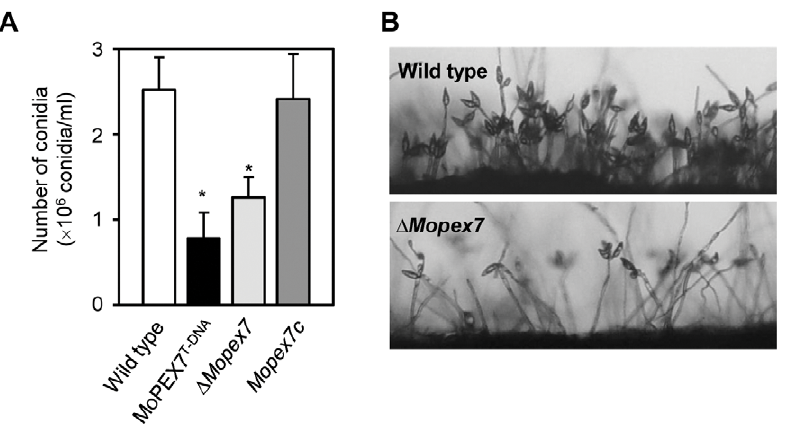
Figure 2. Conidiation and conidiophore differentiation. (A) Conidiation after 10 days post inoculation on oatmeal agar. (B) Conidiophore